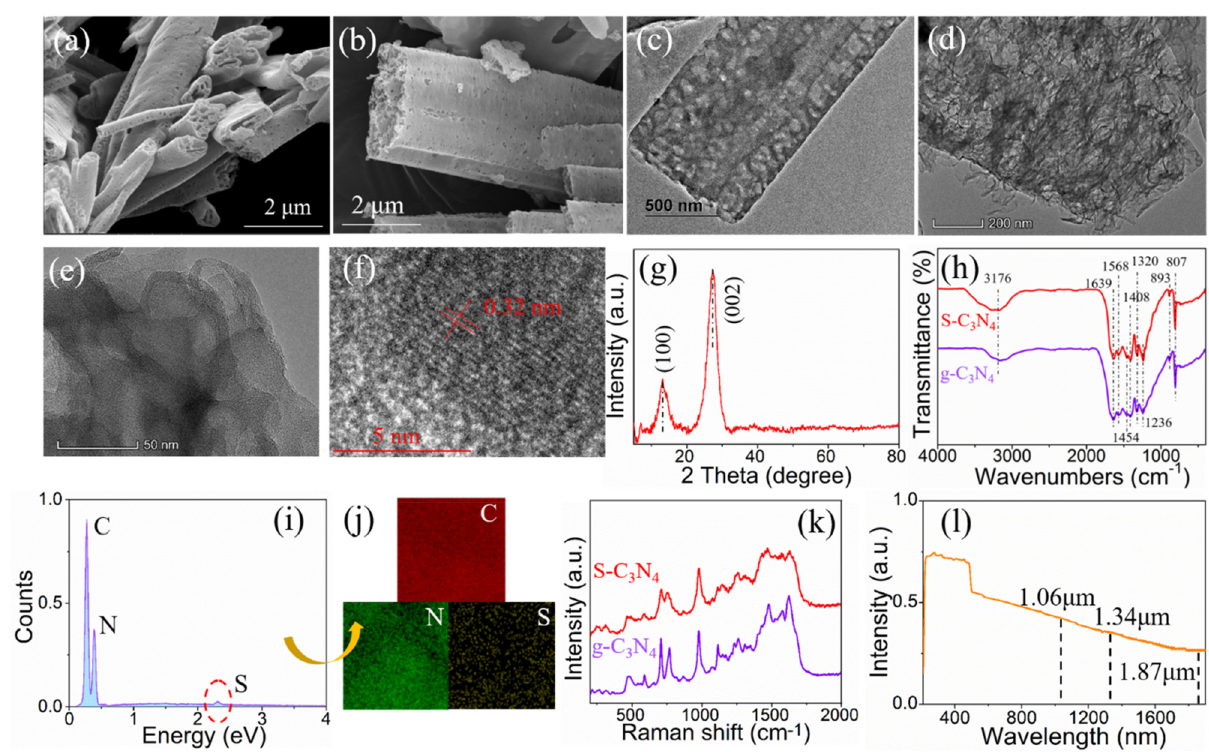
Figure 1: Morphology characterization of the as-prepared S-C 3 N 4 : (a and b) SEM images. (c – f) TEM images with different scales. (g) XRD spectrum. (h) FTIR spectra. (i) EDS image. (j) Elements distribution. (k) Raman spectra. (l) UV – Vis-NIR